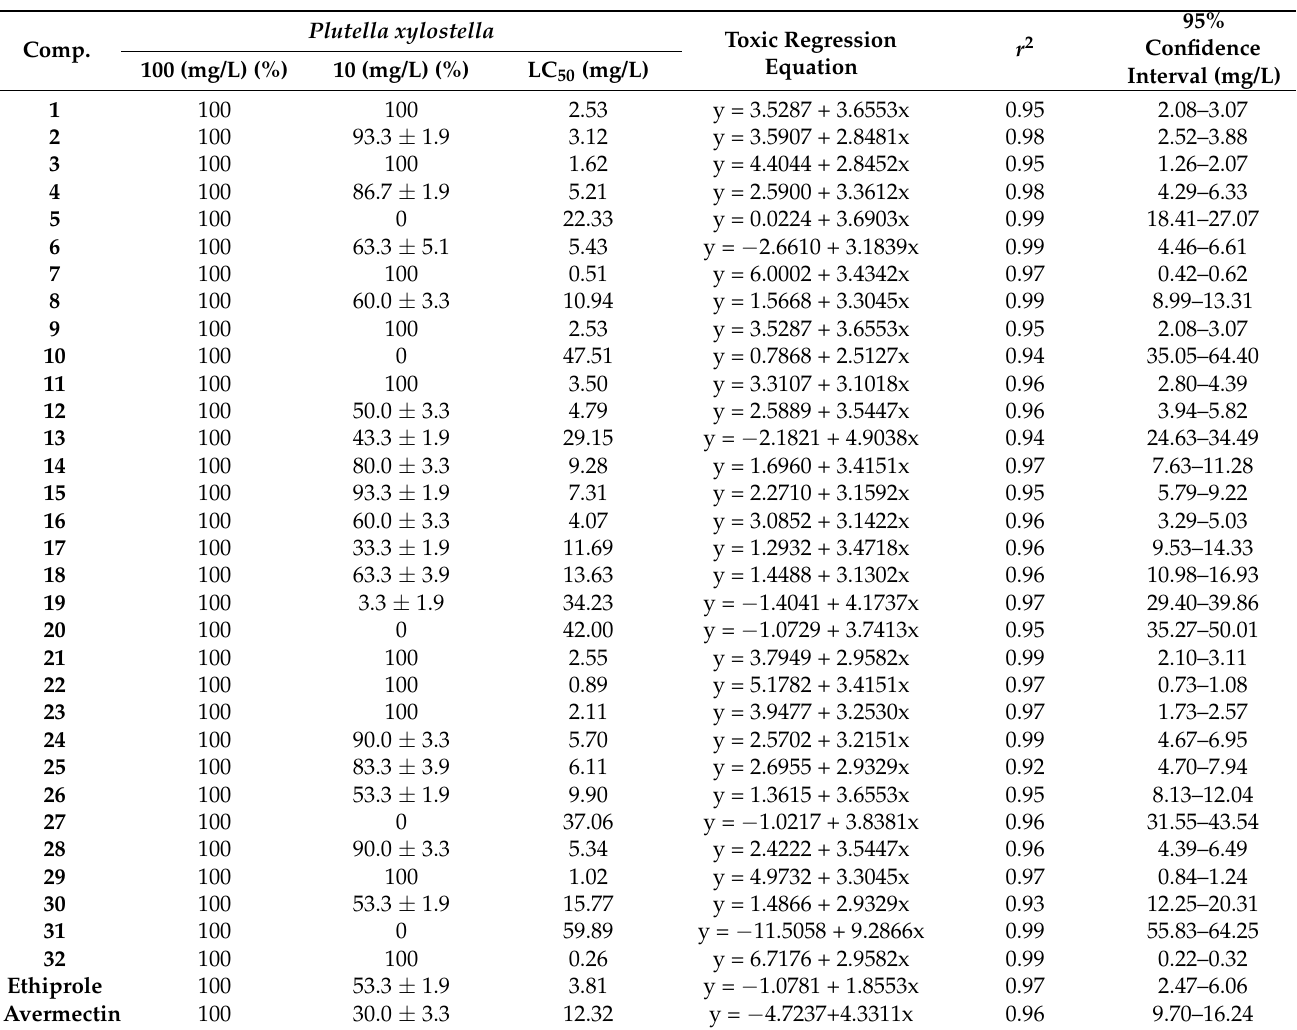
Table 1. Insecticidal activity of compounds against the second instar larvae of Plutella xylostella (48 h).